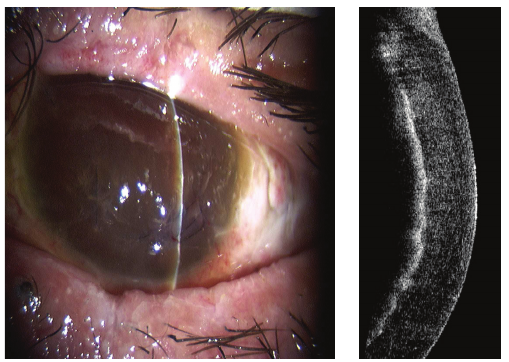
Figure 1: Slit lamp photograph and corresponding AS-OCT image of corneal blood